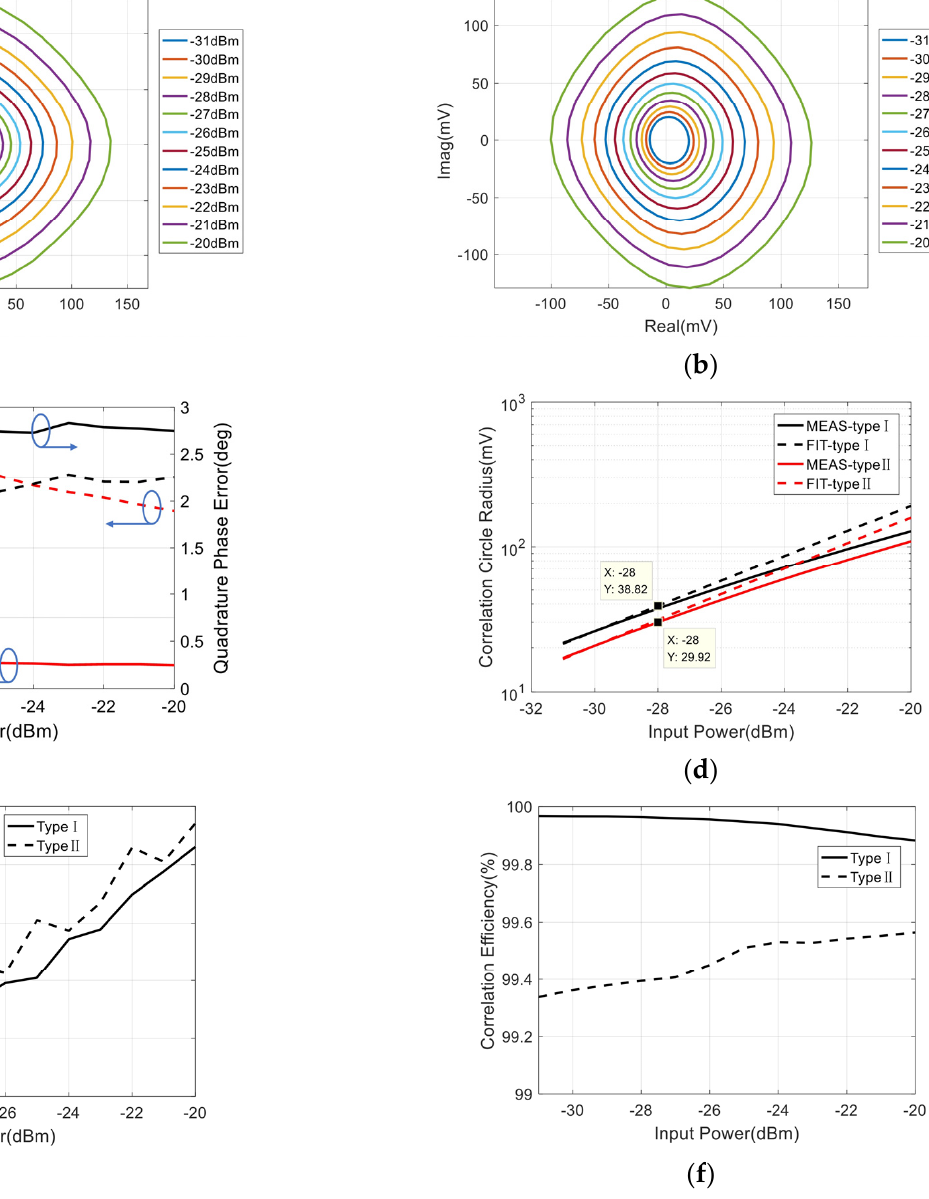
Figure 13. The measurement result of the correlator with input power variation: ( a ) Correlation circle of type Ⅰ correlator; ( b ) Correlation circle of type Ⅱ correlator; ( c ) The quadrature amplitude and phase error of the correlator; ( d ) The correlation circle radius versus input power; ( e ) The maximum phase detection error versus input power; ( f ) The correlation efficiency of the correlator.